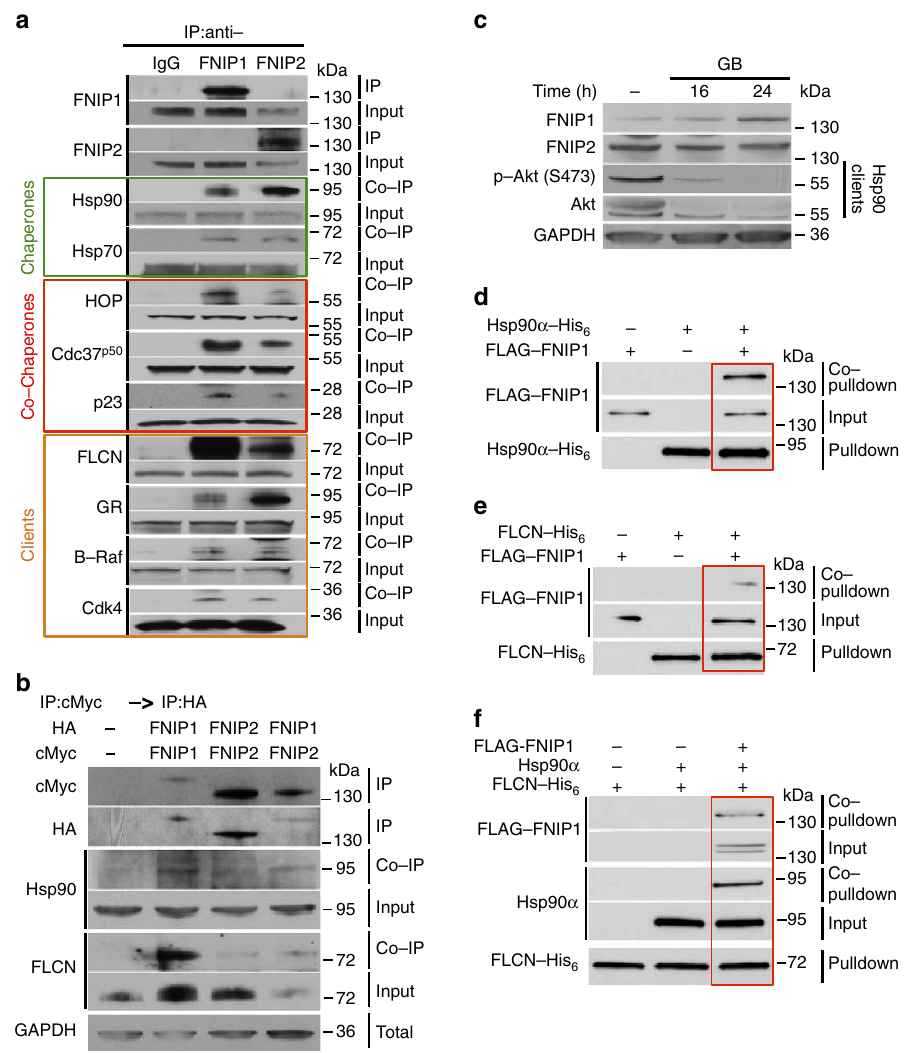
Figure 2 | FNIPs facilitate FLCN binding to the Hsp90 chaperone. ( a ) FNIP1 and FNIP2 were isolated from HEK293 cell lysates using anti-FNIP1, anti- FNIP2 or IgG (control) and immunoblotted with indicated antibodies to confirm protein interaction. ( b ) HA–FNIP1 and HA–FNIP2 were transiently co-expressed with either cMyc–FNIP1 or cMyc–FNIP2 in HEK293 cells. cMyc–FNIP1 and cMyc–FNIP2 were first isolated followed by IP of HA–FNIP1